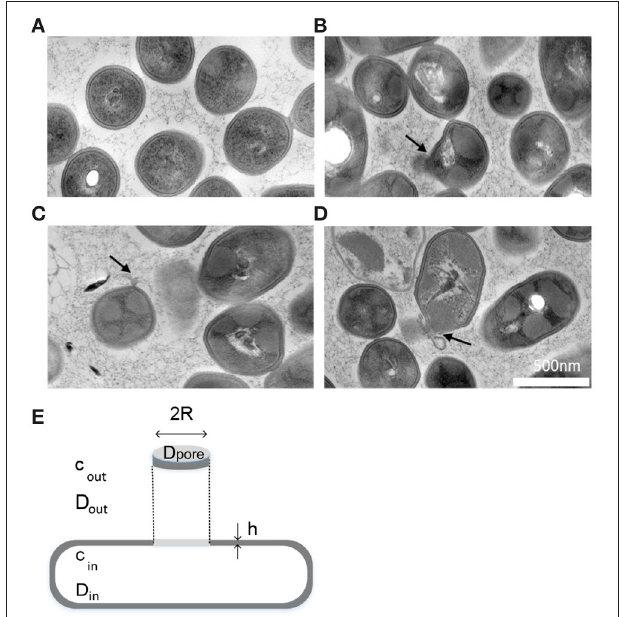
FIGURE 1 | Morphology of pressure-treated cells. (A–D) TEM images showed that HPP could create membrane pores (Nikparvar et al., 2019). (A) Untreated sample, (B–D) Pressure-treated sample, 400 MPa, 15 min. The black arrows show the location of the pore area on the membrane. (E) A schematic model showing the morphology of a created membrane pore area under high pressure. The geometry of the bacterium and its plasma membrane with thickness h is simplified as a rod shape. c in and c out are the concentration of fluorescent molecules inside and outside the cell, respectively, and D in , D out , and D pore are the diffusion coefficient of the fluorescent molecules inside, outside, and within the pore area, respectively. Symbols are defined